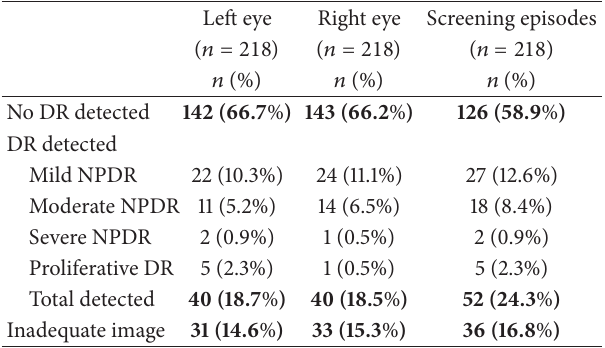
Figure 5: The proportion of screening episodes requiring rescreen- ing due to inadequate images (according to GP management plan) by year. Table 4: Appearance of fundi (GP